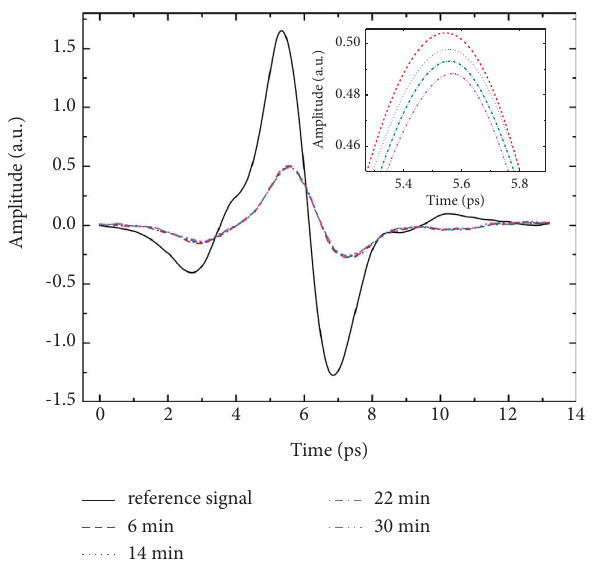
Figure 13: THz time-domain spectra of MWCNT aqueous dis- persion under same MF intensity and diferent time.